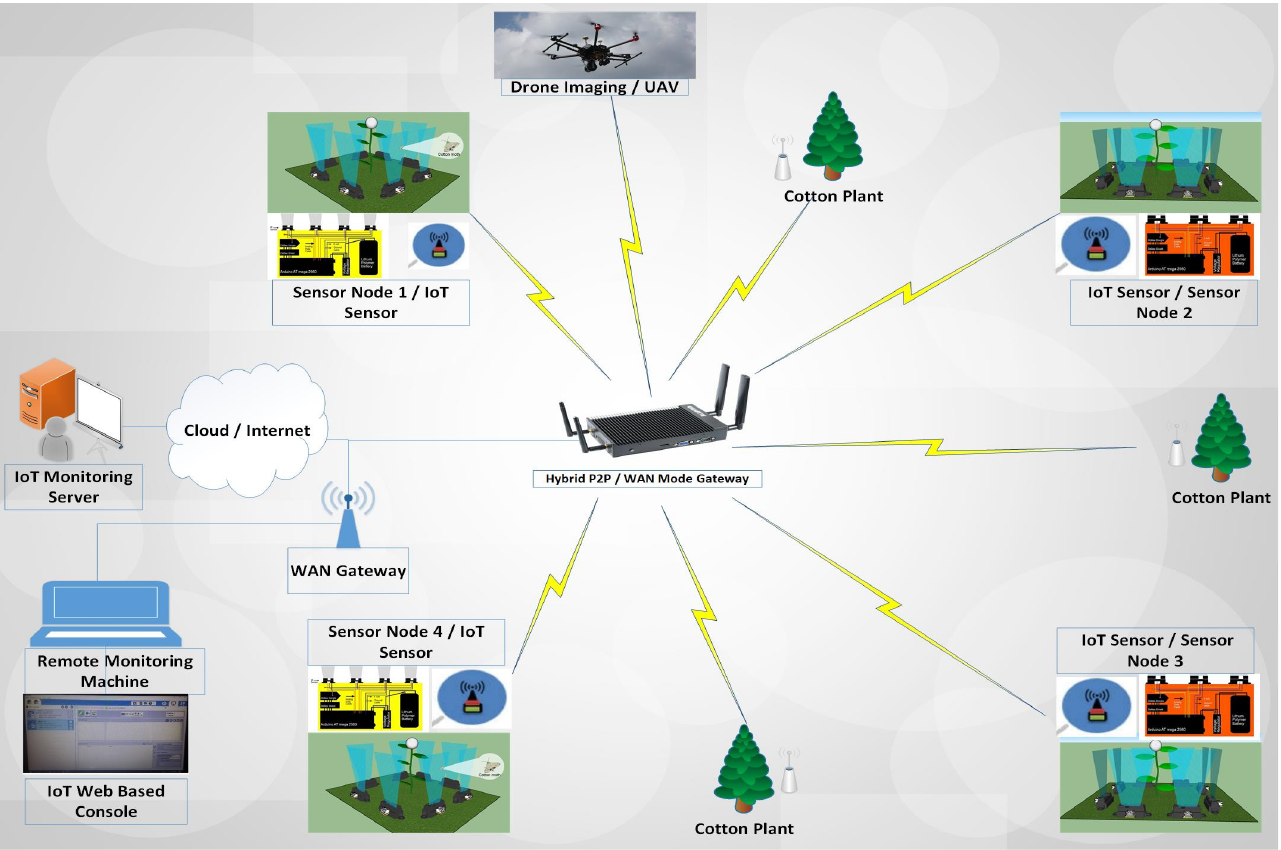
Figure 1. The core architecture of the proposed detection mechanism.